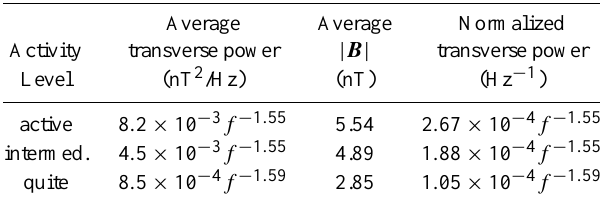
Table 3. Siscoe et al. (1968) standard of IMF active, intermediate and quiet activity Average Average Normalized Activity transverse power | B | transverse power Level (nT 2 /Hz) (nT) (Hz − 1 ) active 8 . 2 × 10 − 3 f − 1 . 55 5.54 2 . 67 × 10 − 4 f − 1 . 55 intermed. 4 . 5 × 10 − 3 f − 1 . 55 4.89 1 . 88 × 10 − 4 f − 1 . 55 quite 8 . 5 × 10 − 4 f − 1 . 59 2.85 1 . 05 × 10 − 4 f − 1 . 59